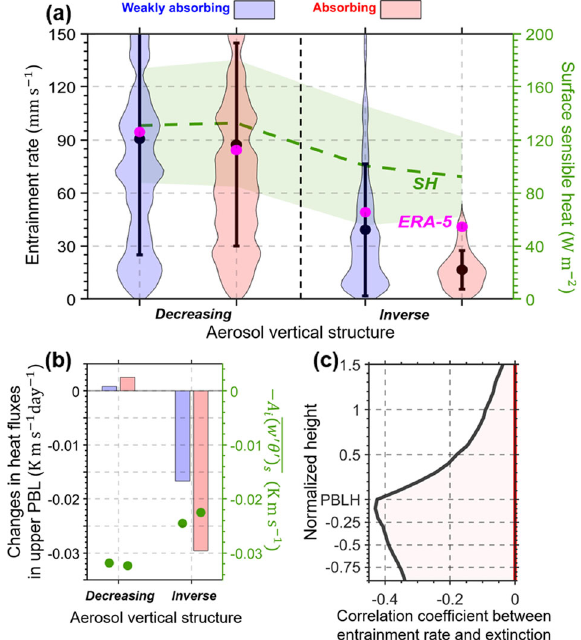
Fig. 3 The PBL entrainment associated with aerosol vertical structures. a The black dot and whisker represent the average value and standard deviation, respectively, of the observed entrainment rates for decreasing/inverse aerosol structures. The width of the color-shaded areas represents the distribution of entrainment rates. In the violin plot 60 , we applied a 3.5 mm s − 1 smooth window for the density distribution. The pink dots indicate the mean values of entrainment rates calculated from ERA-5 reanalysis data. The green dashed line with the shaded area shows the mean and standard deviation of SH. b Aerosol-induced changes in heat fl uxes in the upper PBL for decreasing/inverse aerosol structures. The green dots represent the corresponding mean values of (cid:2) A i ð w 0 θ 0 Þ roughly indicate the expected entrainment fl uxes. In (a, b), blue and red areas indicate weakly absorbing (single-scattering albedo, SSA > 0.9) and absorbing (SSA < 0.85) cases, respectively. c Height- dependent correlation coef fi cients between entrainment rates and aerosol extinction coef fi cients. Note that entrainment rates are fi xed for the atmosphere column, and aerosol extinction coef fi cients are